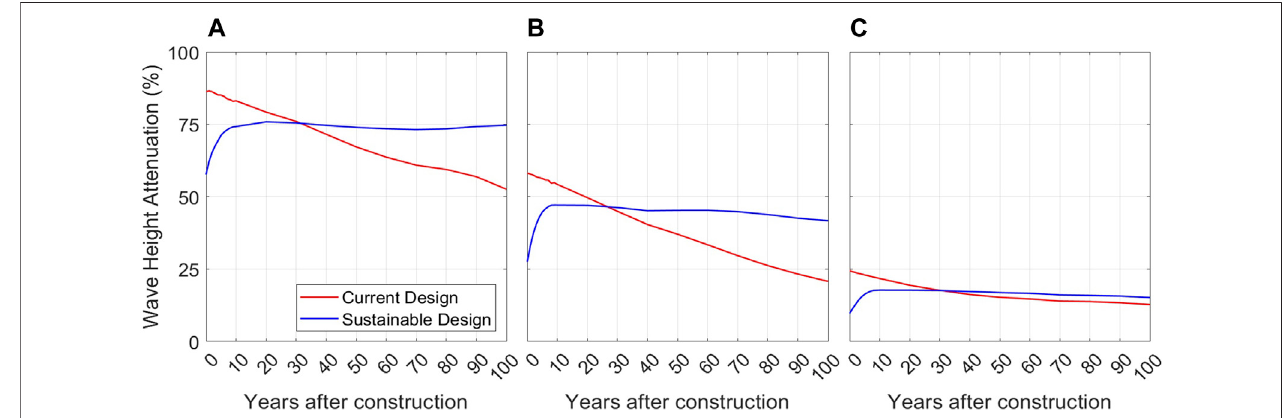
FIGURE 11 | Long-term wave height attenuation with the sustainable and current design of CORs under SLR for three water levels (A) MSL, (B) between MSL and MHW, and (C) MHW.